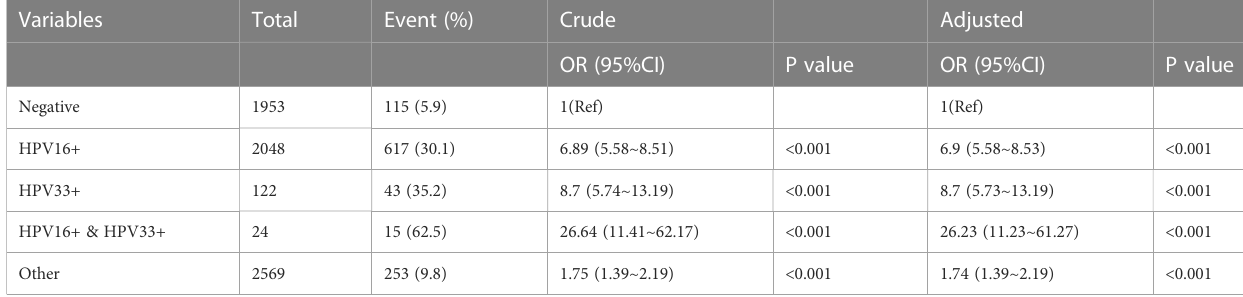
TABLE 4 Multivariate logistic regression analyses of cervical vascular lesions and cervical lesion grades. Cervical vascular lesions Normal Abnormal Model adjustments for age, gravidity, and parity.